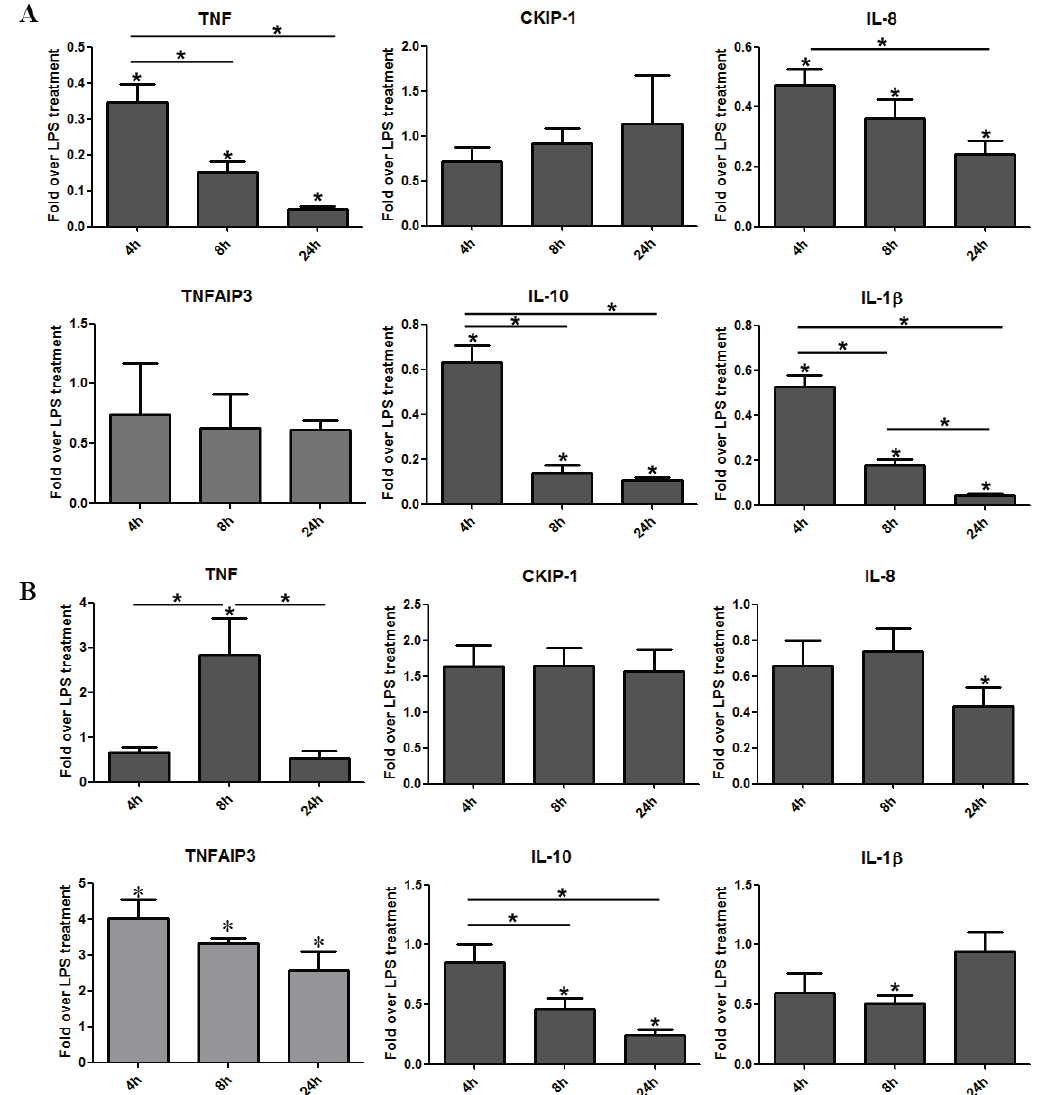
Figure 4. The effect of CZP-induced reverse signaling on LPS-induced gene expression in THP-1 and U937 human monocytes. THP-1 ( A ) and U937 ( B ) human monocytes were pretreated with LPS to induce inflammatory response. Two hours later, CZP was added. Total RNA was harvested 4, 8, and 24 h after the addition of CZP. The regulatory effect of CZP treatment was time-dependent. In the case of both THP-1 and U937 cells, mild relative expression upregulation was detected in the CKIP-1 gene, suggesting the induction of reverse signaling. Data show the average ± SEM from at least three independent experiments. * Significantly different from unstimulated controls (One-Way ANOVA following Neuman–Keuls post hoc